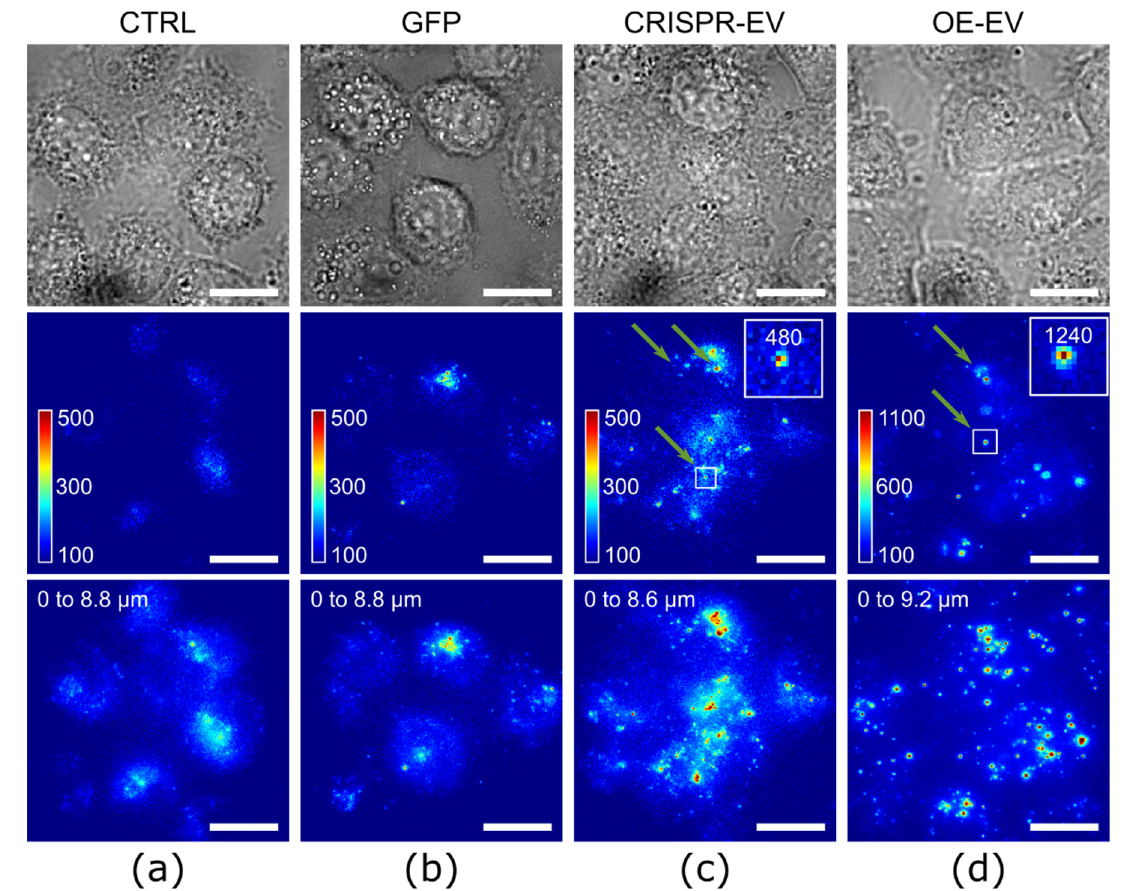
Figure 4. Intracellular imaging of GFP-labeled EVs. The HeLa cells were incubated with ( a ) PBS (CTRL), ( b ) recombinant GFP-protein (GFP), ( c ) CRISPR-EVs, or ( d ) OE-EVs for 1.5 h. The fluorescence images of one z-level (cross-section through the middle of the cell) are shown in the middle panel and the z-projections are shown in the lower panel. The arrows indicate the typical fluorescence signals of EVs. The scale bar is 10 µm.